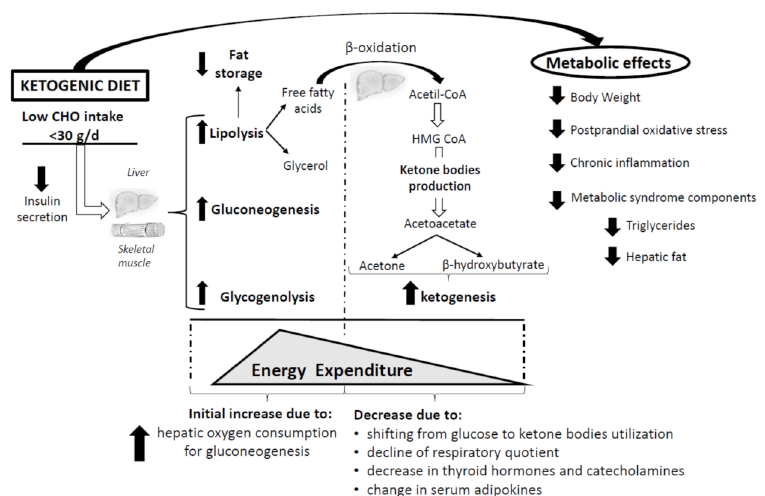
Figure 1. Metabolic effects of ketogenic diets. Carbohydrates are the primary source of energy production in body tissues. When carbohydrate intake is less than 30 g per day, insulin secretion decreases, leading to an increase in glycogenolysis, gluconeogenesis, and lipolysis. When glucose disposal decreases further, gluconeogenesis cannot replace the necessary needs of the body. Thus, the increased lipolysis leads to the enhanced production of free fatty acids which, in turn, are converted to Acetil-CoA through beta-oxidation. This process leads to the production of ketone bodies (acetoacetate, acetone, and 3- β -hydroxybutyrate) that provide “extra fuel” to various tissues. The beneficial metabolic effects of the KDs are represented on the right side of Table 1. Regarding the effects on energy metabolism, it has been hypothesized that a rapid increase in EE may initially occur due to increased hepatic oxygen consumption for gluconeogenesis. Later, a decrease in 24-h EE occurs due to the slowing of gluconeogenesis, a decrease in the respiratory quotient due to increased utilization of ketone bodies, a reduction of thyroid hormones and catecholamines, and changes in serum adipokines. g/d: grams per